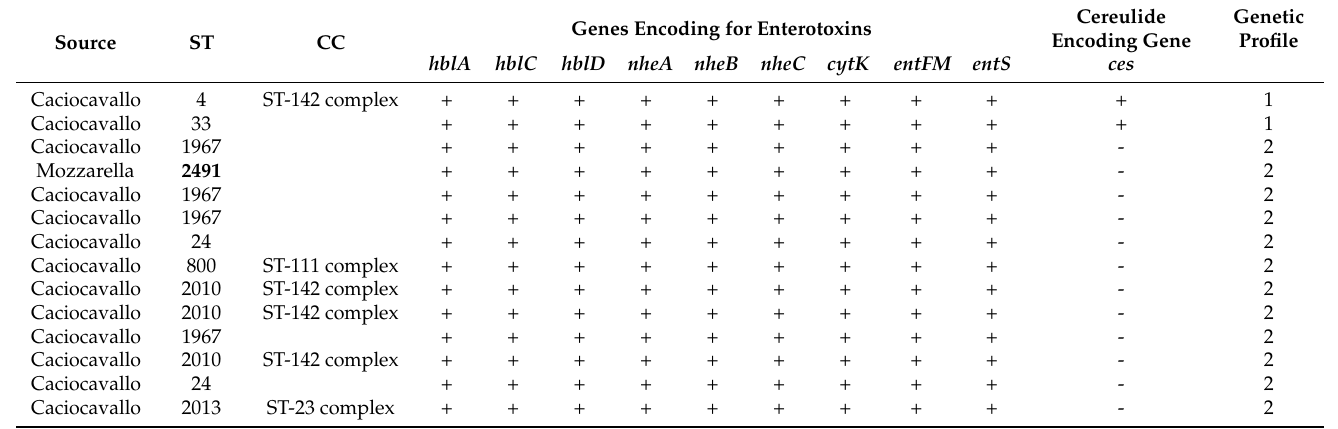
Table 2. Characterization and virulence genetic profile of the B. cereus s.l. isolated from cheeses and milk. The STs identified for the first time were indicated in